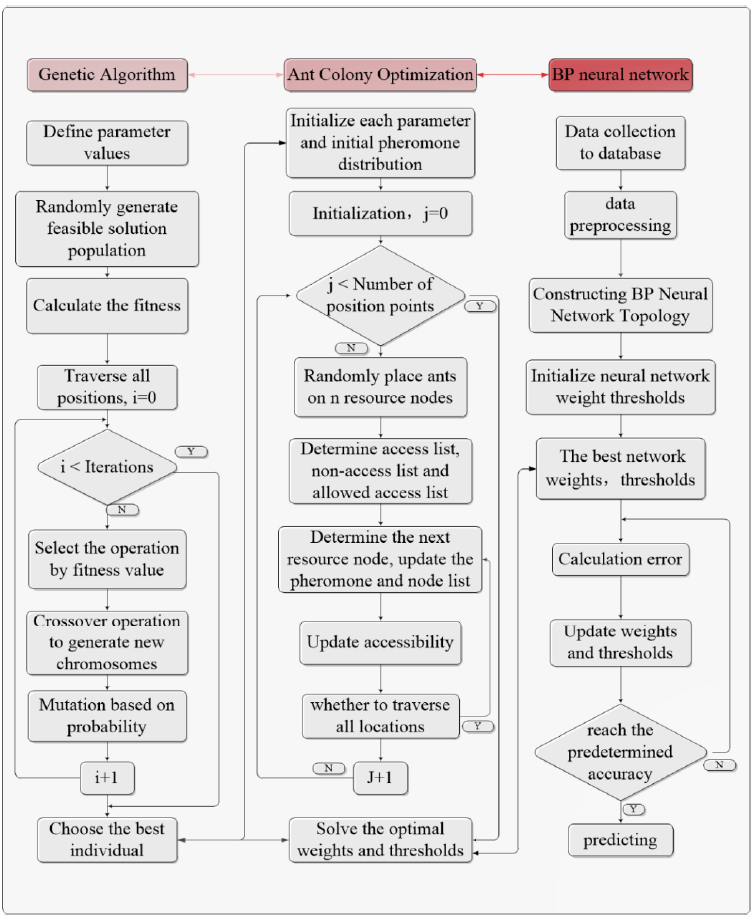
Figure 3. GA – ACO – BP neural network prediction model. Figure 3. GA–ACO–BP neural network prediction